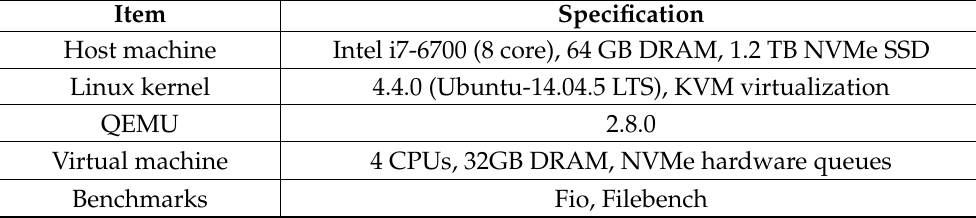
Table 1. Experimental environment.